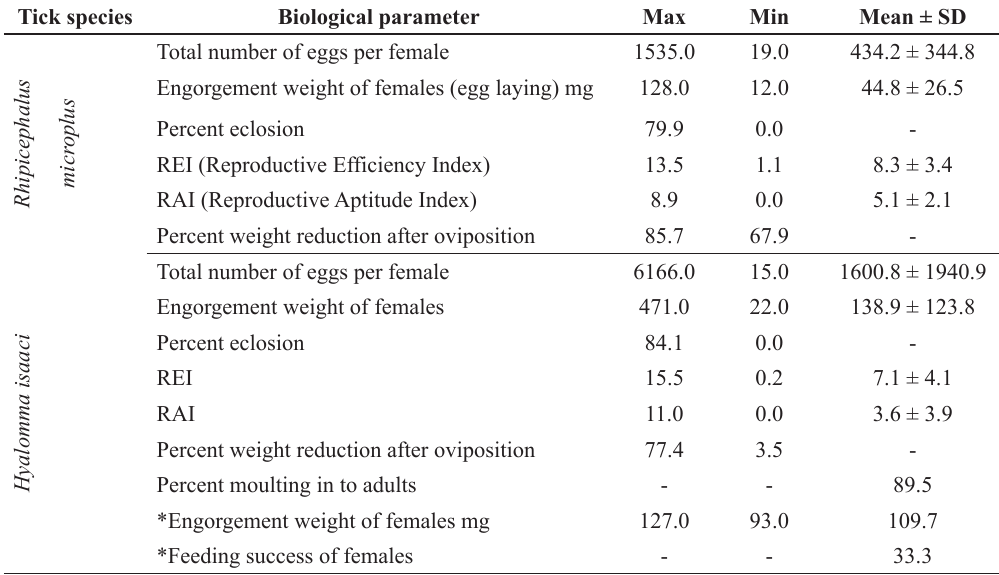
* indicates the adults (females) which were raised in the pattern (Figure 4). Wild Females laid 15 - 6,166 (mean ±